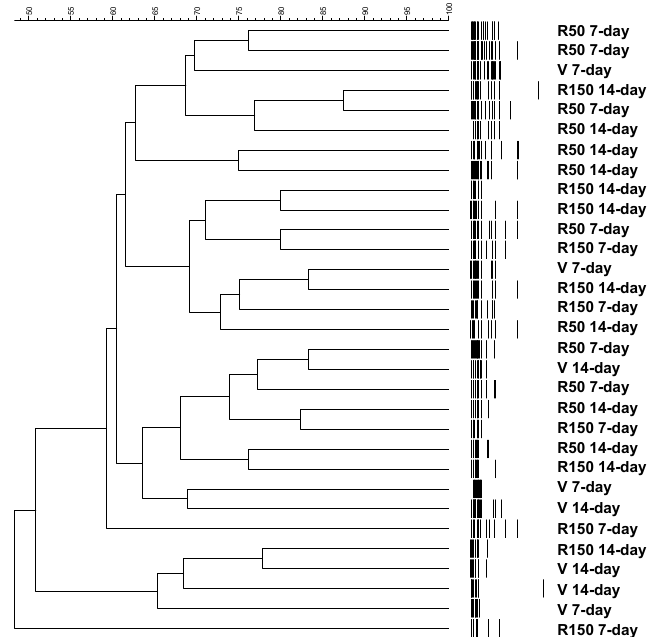
Figure 3. Ecological characterization of the luminal microbiota by T-RFLP analysis. Dendrogram showing the distribution of the different experimental groups according to the T-RFLP banding patterns obtained from the analysis of the ceco-colonic samples. Each line represents an animal identified by either R50 (rifaximin at 50 mg/kg), R150 (rifaximin at 150 mg/kg) or V (vehicle), fol- lowed by the experimental period (7-day or 14-day). The dendrogram distances represent percentage of similarity. The different experimental groups did not cluster together indicating the absence of treatment-related changes in the microbiota composition.